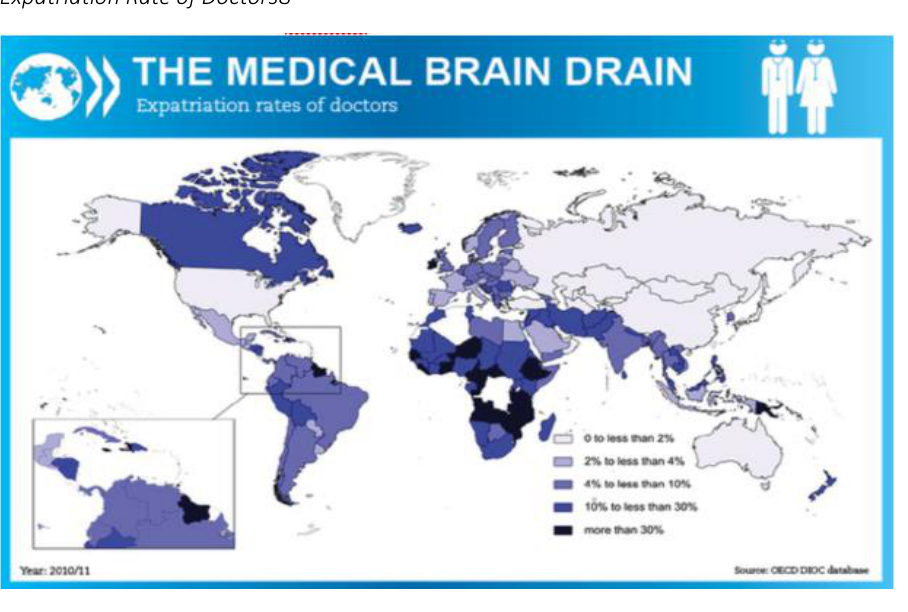
Table 1. Global Health Workforce by Density